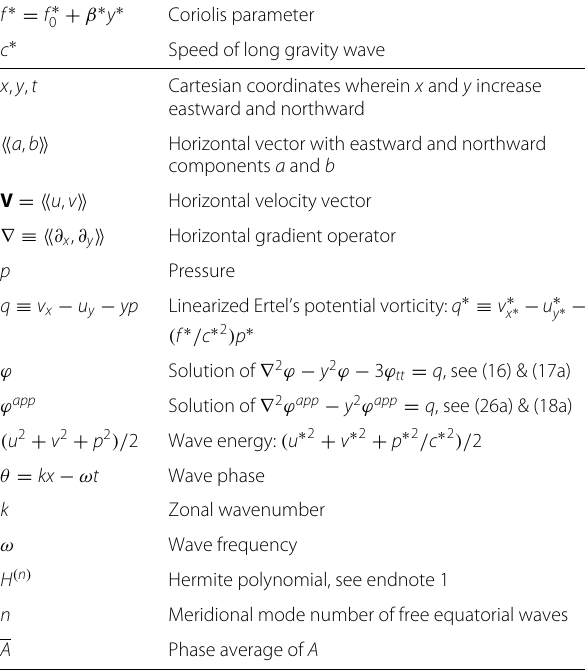
written dimensionally or non-dimensionally,